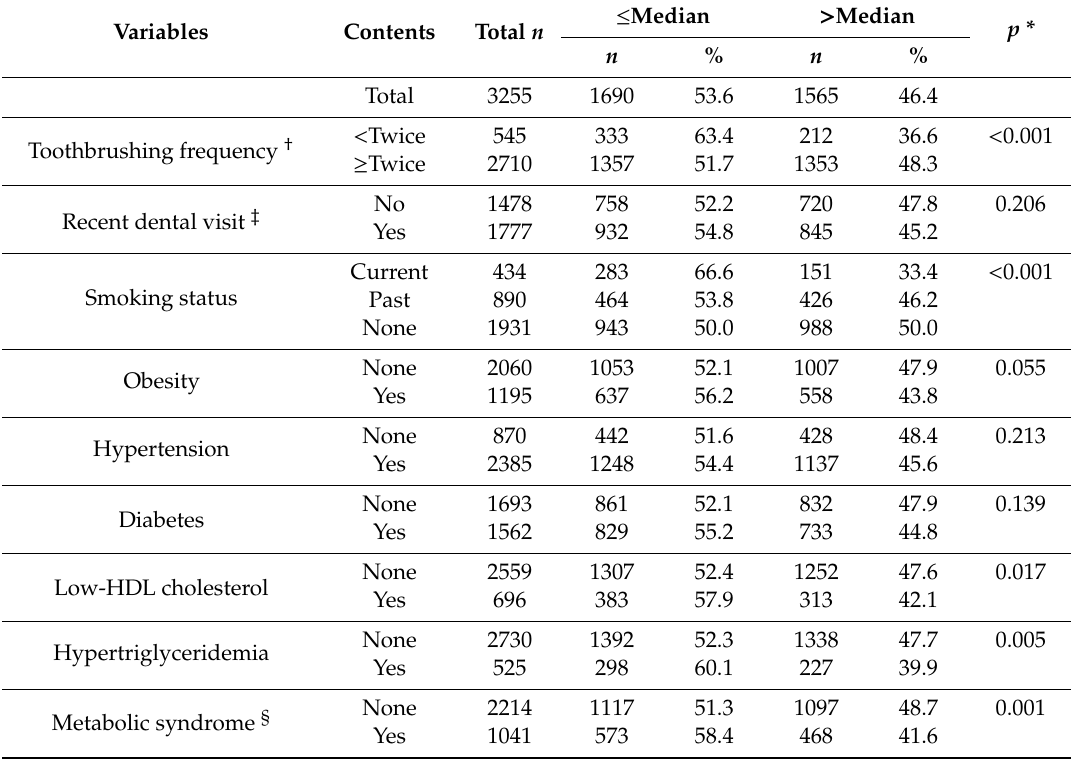
Table 4. Binary status based on the median number of existing teeth by oral health-related behaviours and metabolic syndrome status among participants aged 55–79